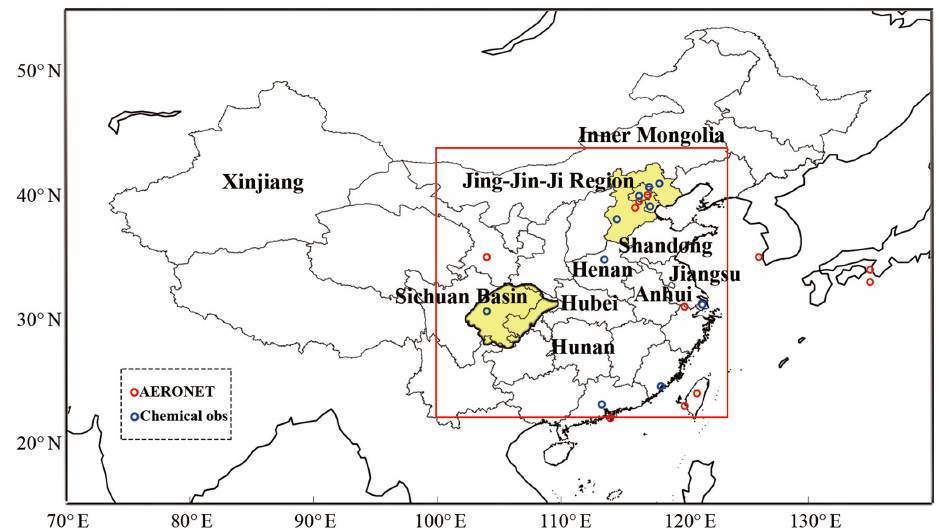
Figure 2. Geographical locations of the AERONET sites and chemical composition sites where the observational data are used in this study. The provinces and regions mentioned in the context are marked. The red rectangle denotes eastern China (22–44 ◦ N, 100–124 ◦